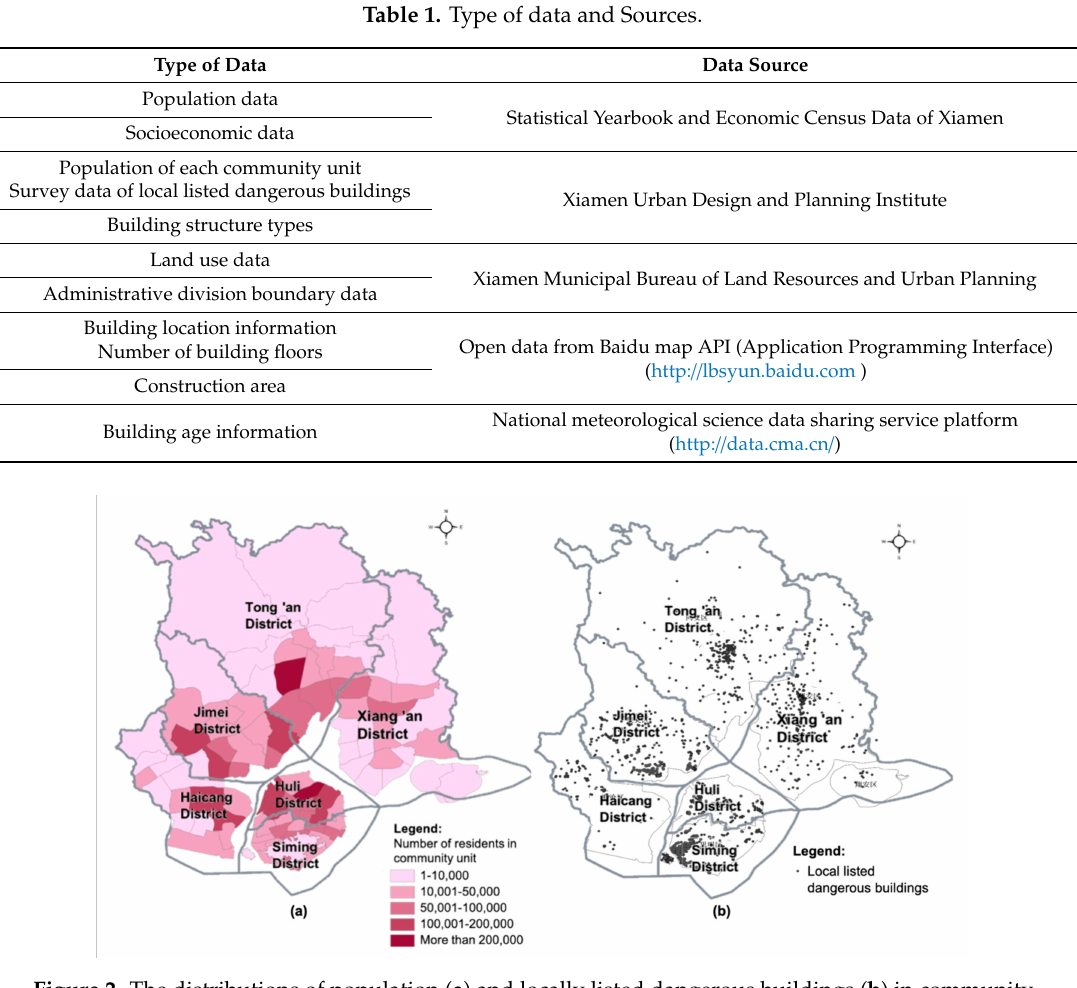
Figure 2. The distributions of population ( a ) and locally listed dangerous buildings ( b ) in community units in